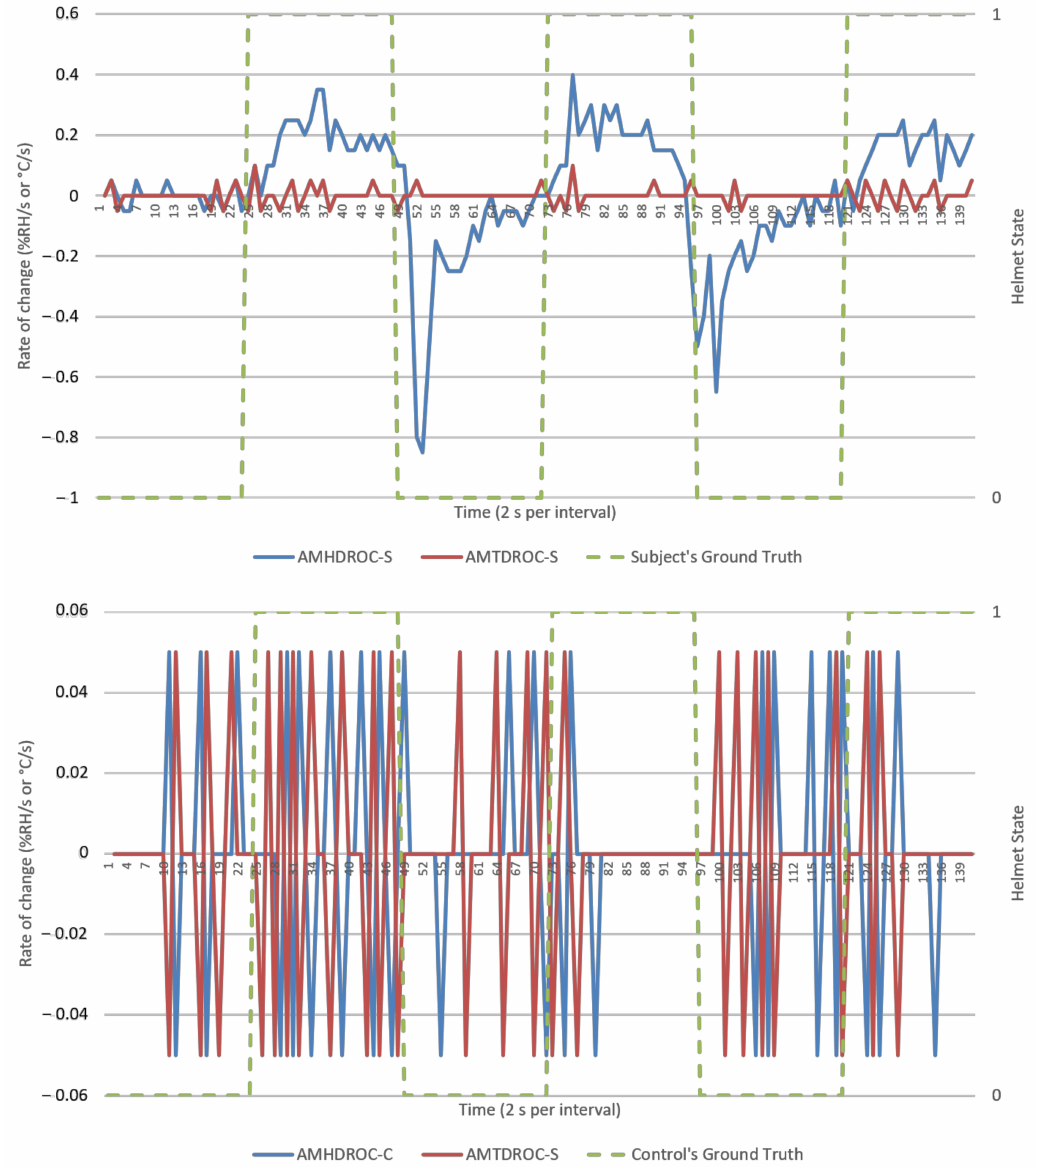
Figure 12. AMDROCs versus time (2 s per interval) from a typical M run, human subject ( top ), and experiment control ( bottom ). Helmet state 0 = NW and 1 =